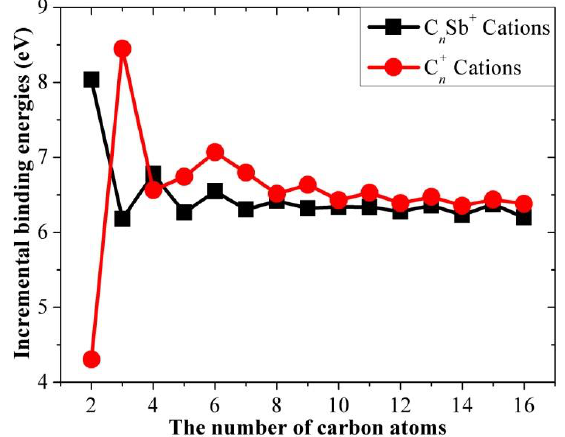
Figure 13. Incremental binding energies of C n Sb + cations and pure C n cations as a function of the number of carbon atoms.